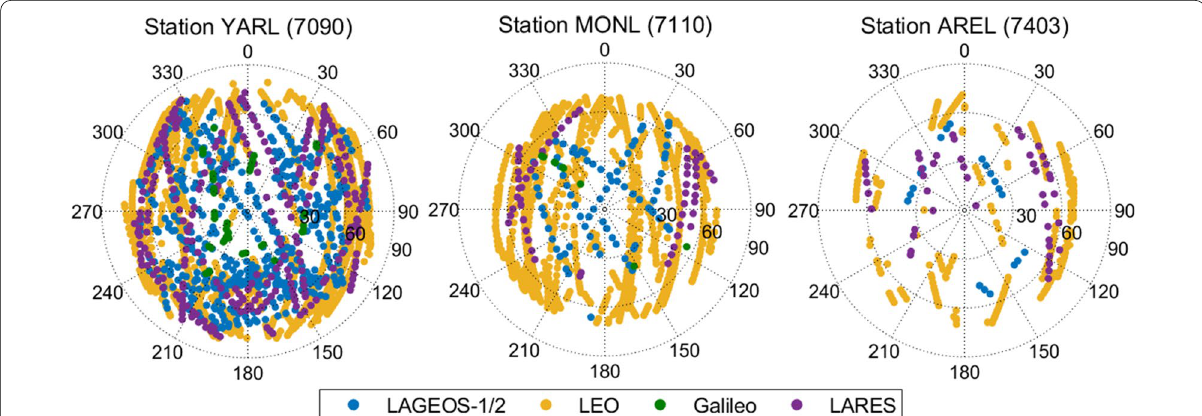
Fig. 4 Distribution of SLR NPs for station azimuth and zenith angles to LAGEOS-1/2, LEO, Galileo, and LARES satellites from the period of June 1–7, 2016. An example for Yaragadee (7090, left), Monument Peak (7110, middle), Arequipa (7403, right) station